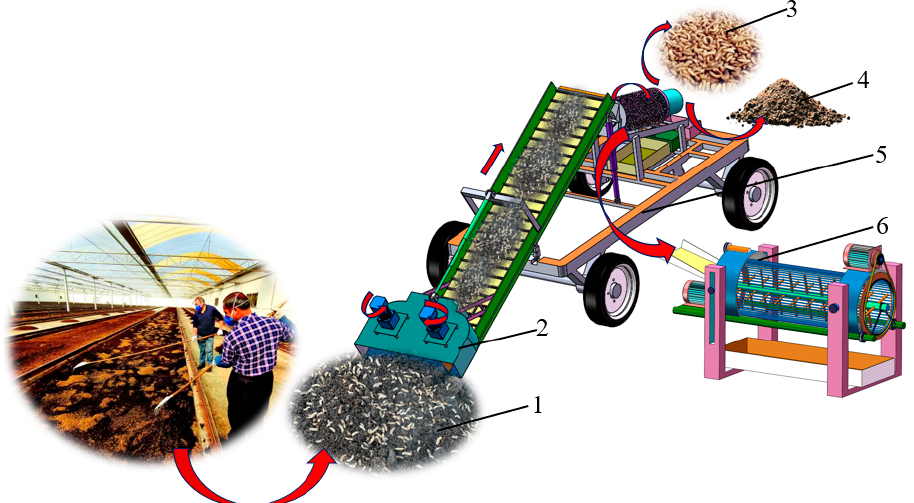
Figure 4. Structure and working principle of the ground trough BSF sand conveying and sorting machine. 1—BSF mixture; 2—parallel double-impeller collecting device; 3—BSF larvae; 4—BSF frass; 5—chassis; 6—sieve device with different rotational speeds.